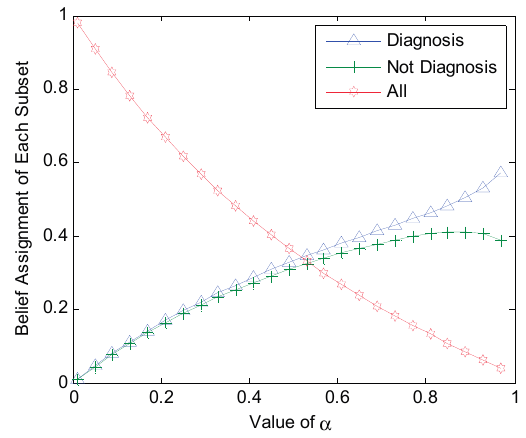
Figure 4. BBAs obtained with different (cid:2009) .